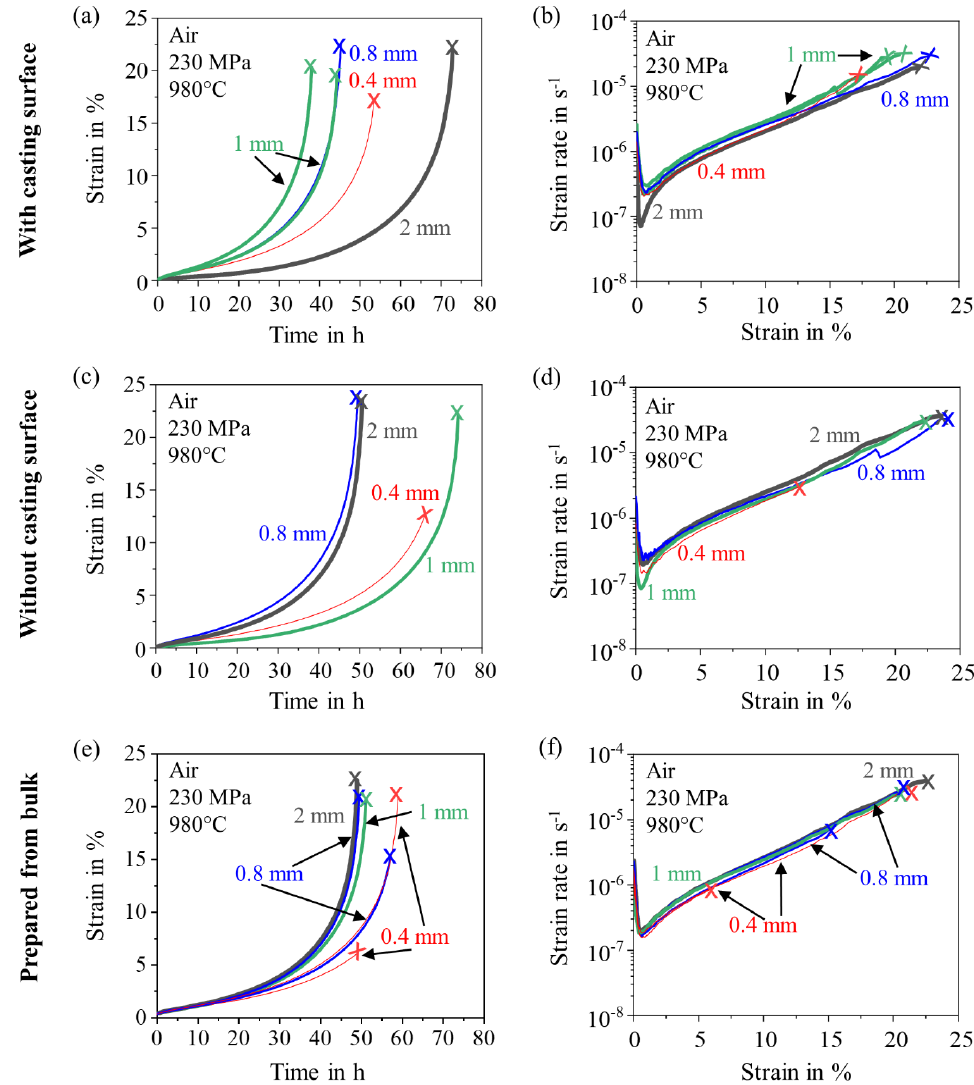
Figure 6. Creep curves of specimens with various thickness tested in air at 980 °C under a high stress of 230 MPa: ( a , b ) with casting surface, ( c , d ) without casting surface, ( e , f ) prepared from bulk material.